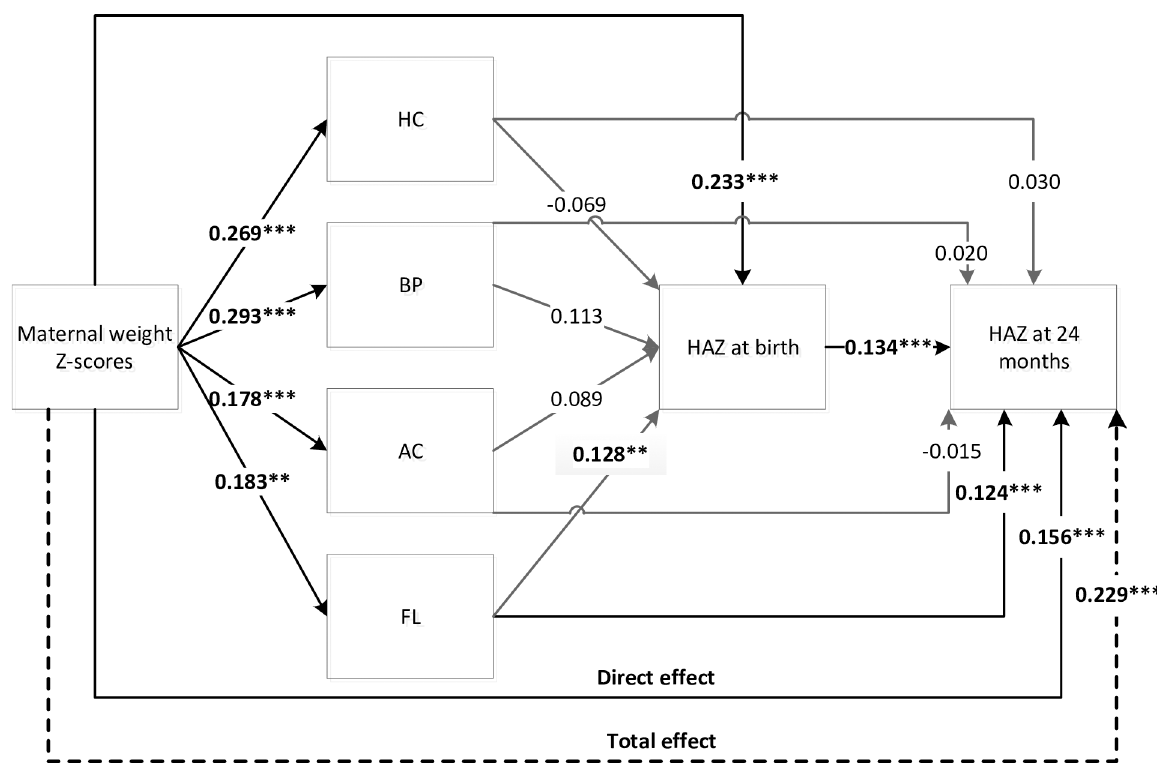
Fig 3. Direct and indirect effects of maternal weight Z-scores on offspring HAZ at 2 years. Direct and indirect effects of maternal weight Z- scores on offspring HAZ at 2 years. AC, abdomen circumference, BP, Biparietal diameter; FL, femoral length; HAZ, height for age Z-score; HC, head circumference. Significant differences from two-tailed tests: (cid:3)(cid:3)(cid:3) p < 0.001, (cid:3)(cid:3) p < 0.01, (cid:3) p < 0.05. Total effects: 0.23 SD (cid:3)(cid:3)(cid:3) (including direct 0.16 SD (cid:3)(cid:3)(cid:3) and indirect 0.07 SD (cid:3)(cid:3)(cid:3) effects).